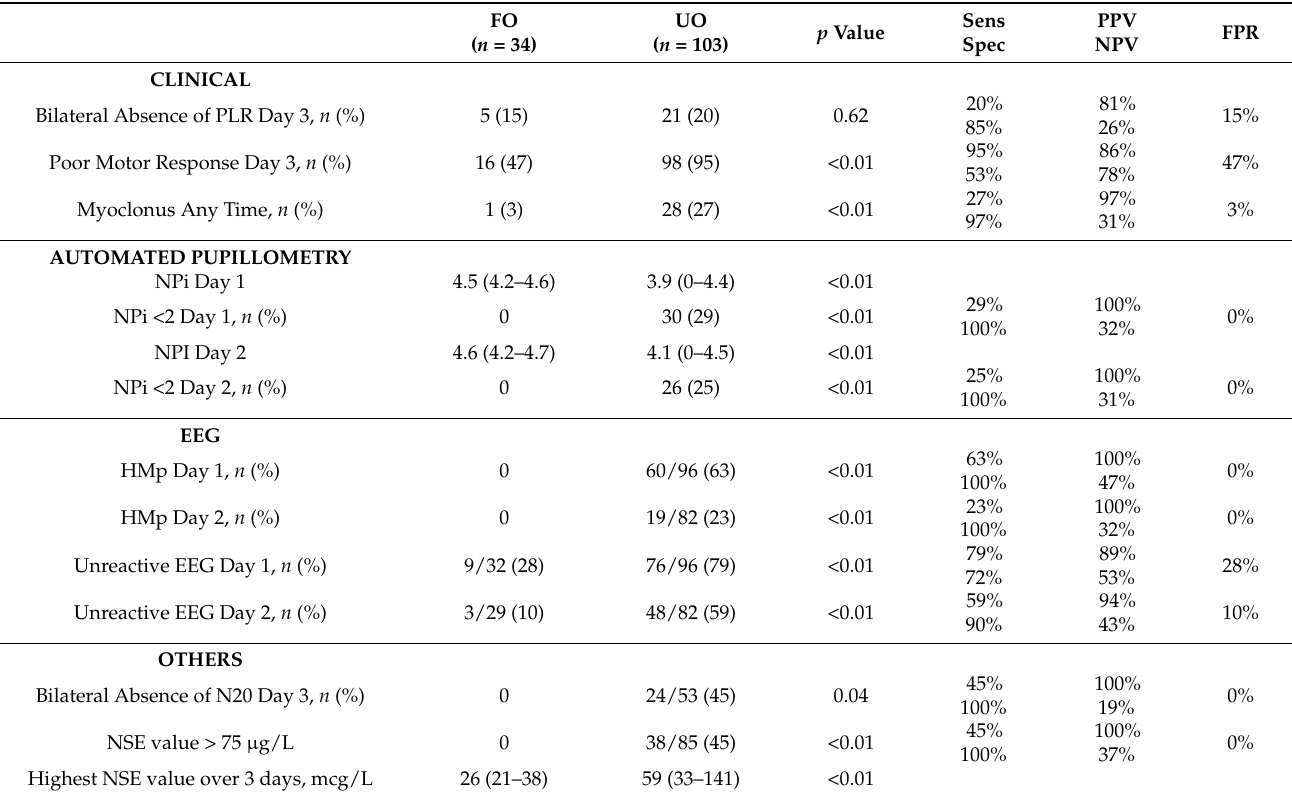
Table 2. Different prognostic tools according to neurological outcome (FO, favourable; UO, unfavourable). FO ( n =